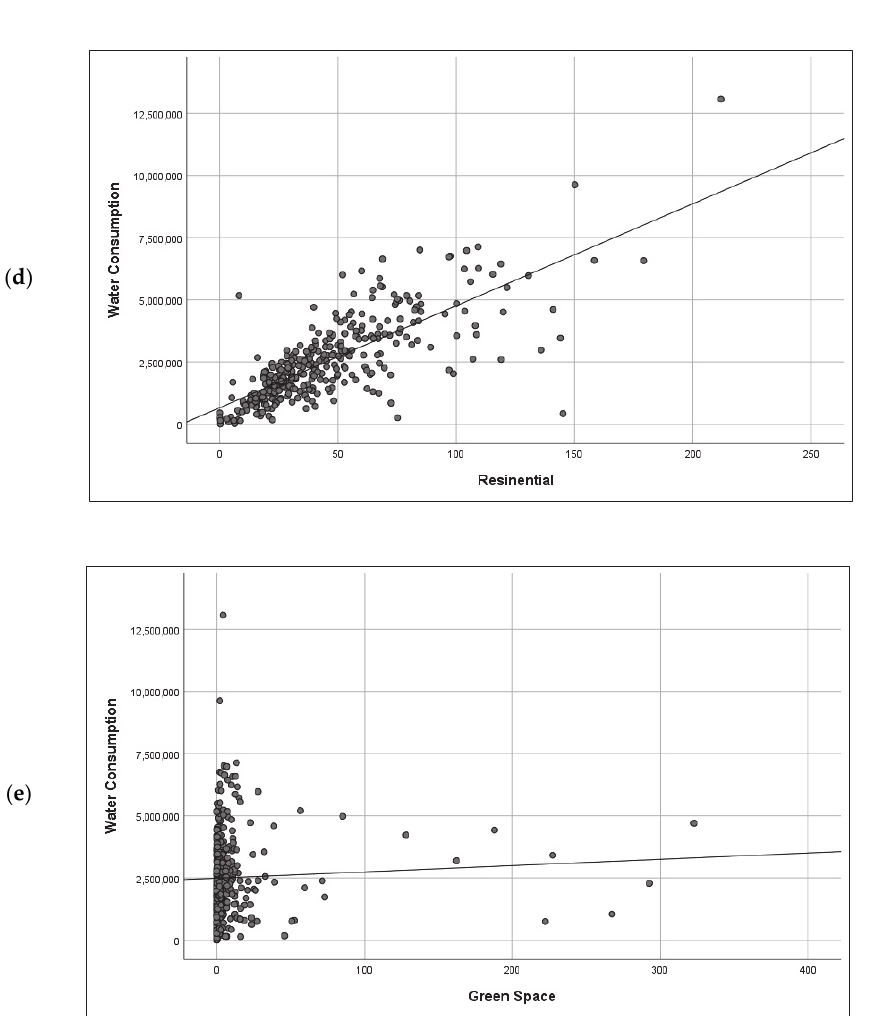
Figure 6. Correlation diagram of water consumption with significant land use factors: ( a ) residential–urban service; ( b ) commercial–urban service; ( c ) residential–commercial; ( d ) residential; ( e ) green space.